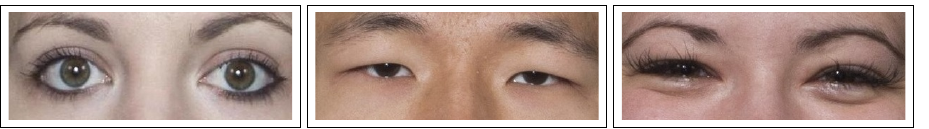
Figure 3. Illustration of the challenges of correctly detecting the aperture of eye opening as widely open ( left ), based on ethnicity ( center ) and inclusion of emotions ( right ). Images originate from LondonDB [46] dataset with application of